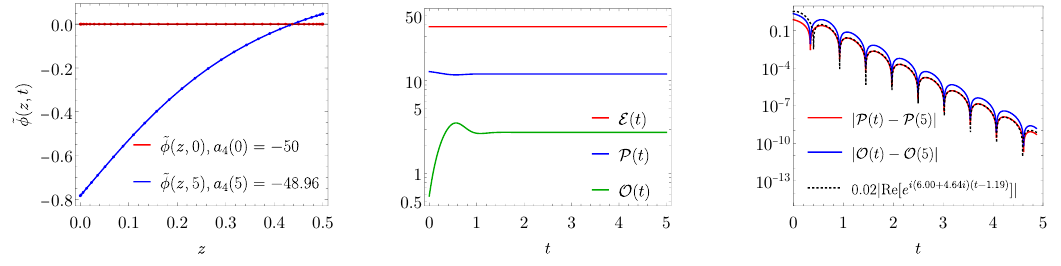
Figure 2 . Construction of initial states in flat space. All dimensionful quantities are given in units of M and we choose the renormalisation scheme β = 1 / 16 . (Left) Initial guess (red) and resulting thermalised equilibrium configuration (blue) for the scalar field profile. (Center) Evolution of E ( t ) , P ( t ) and O ( t ) . (Right) Ring-down of |O ( t ) − O (5) | (blue) and |P ( t ) − P (5) | (red) together with an exponential fit for the lowest quasinomal mode ω 1 ≈ 6 . 00 + 4 . 64 i (doted